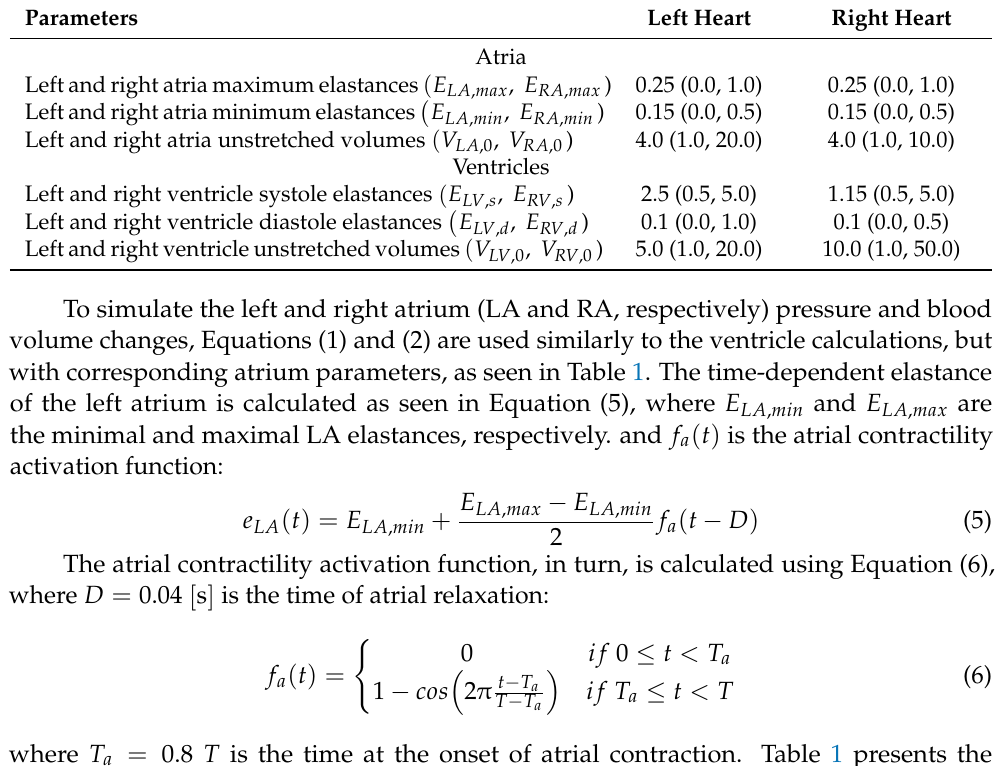
Table 1. Nominal heart model parameters (values in parentheses indicate upper and lower boundaries for sensitivity analysis and normalization) [20]. Parameters Left Heart Right Heart Atria Left and right atria maximum elastances ( E LA , max , E RA , max ) 0.25 (0.0, 1.0) 0.25 (0.0, 1.0) (cid:0) E LA , min , E RA , min ) 0.15 (0.0, 0.5) 0.15 (0.0, 0.5) Left and right atria minimum elastances Left and right atria unstretched volumes ( V LA ,0 , V RA ,0 ) 4.0 (1.0, 20.0) 4.0 (1.0, 10.0) Ventricles Left and right ventricle systole elastances ( E LV , s , E RV , s ) 2.5 (0.5, 5.0) 1.15 (0.5, 5.0) (cid:0) E LV , d , E RV , d ) 0.1 (0.0, 1.0) 0.1 (0.0, 0.5) Left and right ventricle diastole elastances Left and right ventricle unstretched volumes ( V LV ,0 , V RV ,0 ) 5.0 (1.0, 20.0) 10.0 (1.0,